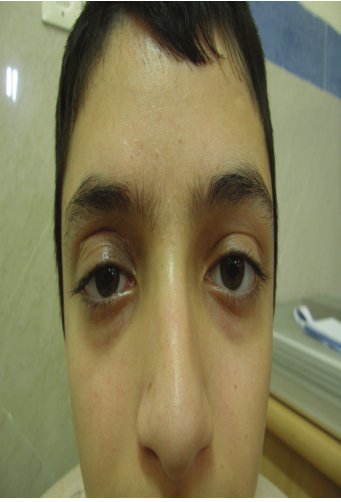
Figure 6: Good cosmesis and successful outcome of patient 6 months after